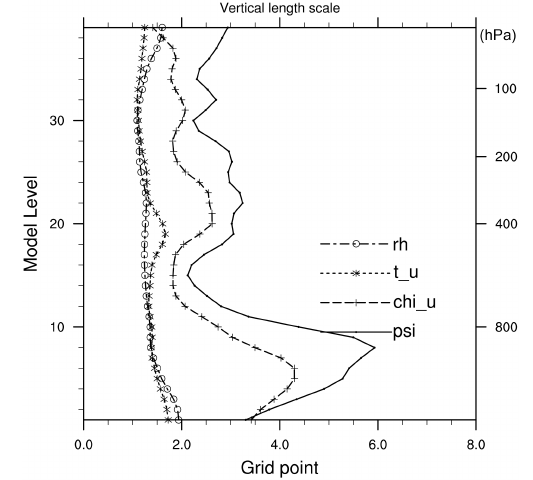
Figure 8. Length scales defined in grid point through EOF mode for CV5. The analysis control variables representing the dynamical variables, psi and chi u , have longer length scales than t u and RH (WRF, res. 15km, D-ensemble, EOFs).